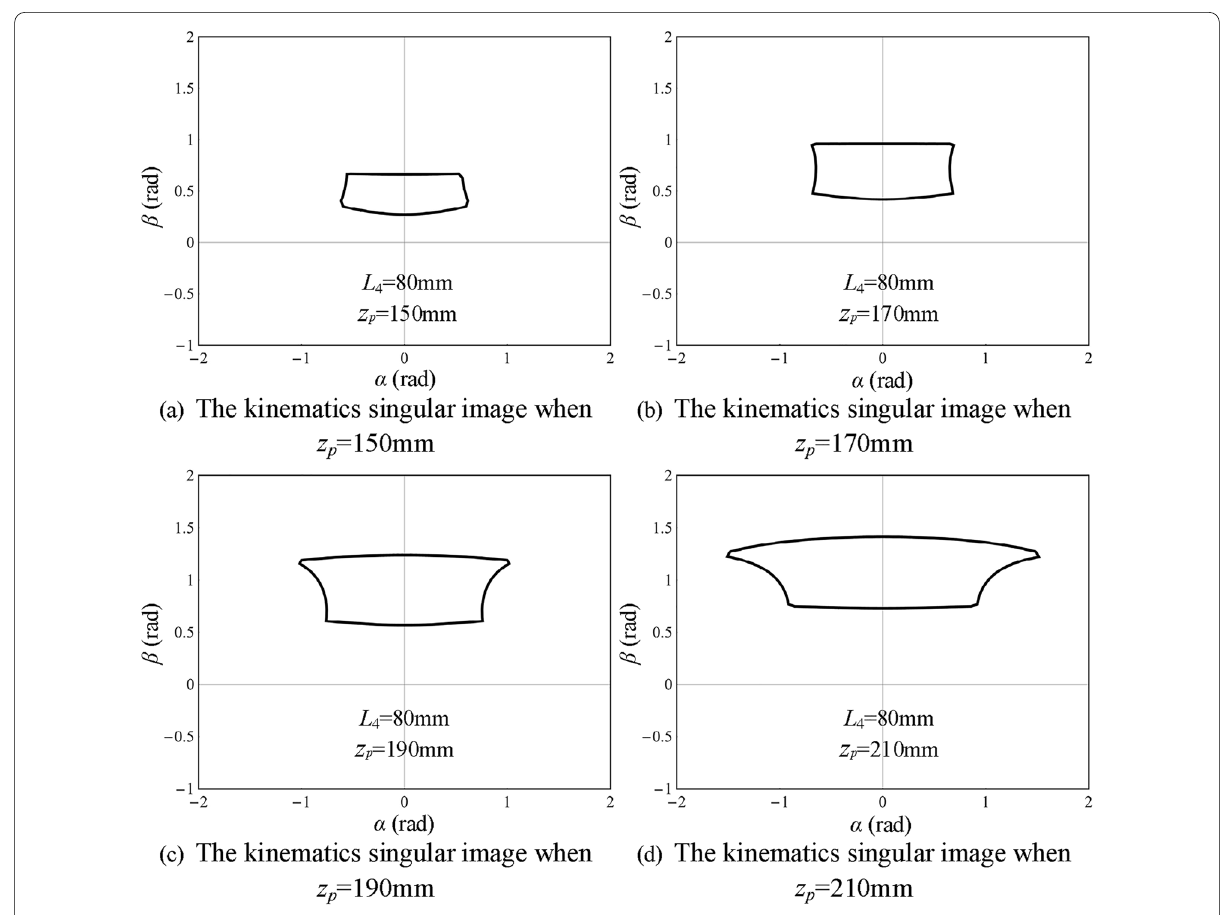
Figure 8 The singularity diagram of the mechanism when z p takes different values